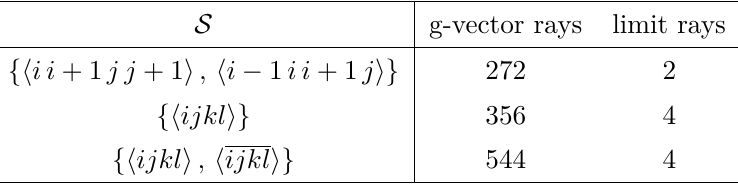
Table 1 . Number of rays of the fans F ( S ) for different choices of S